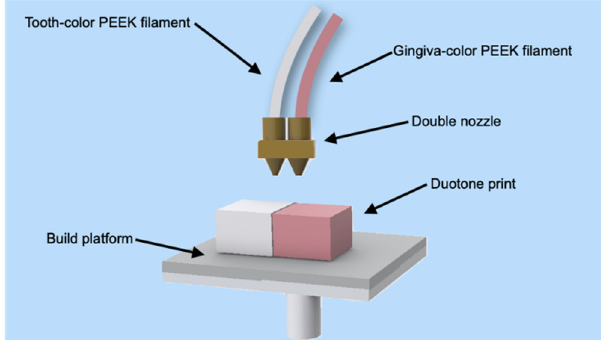
Figure 3. Illustration of dual-nozzle printing of the duotone specimens using white and pink polyetheretherketone (PEEK) filaments, simultaneously.